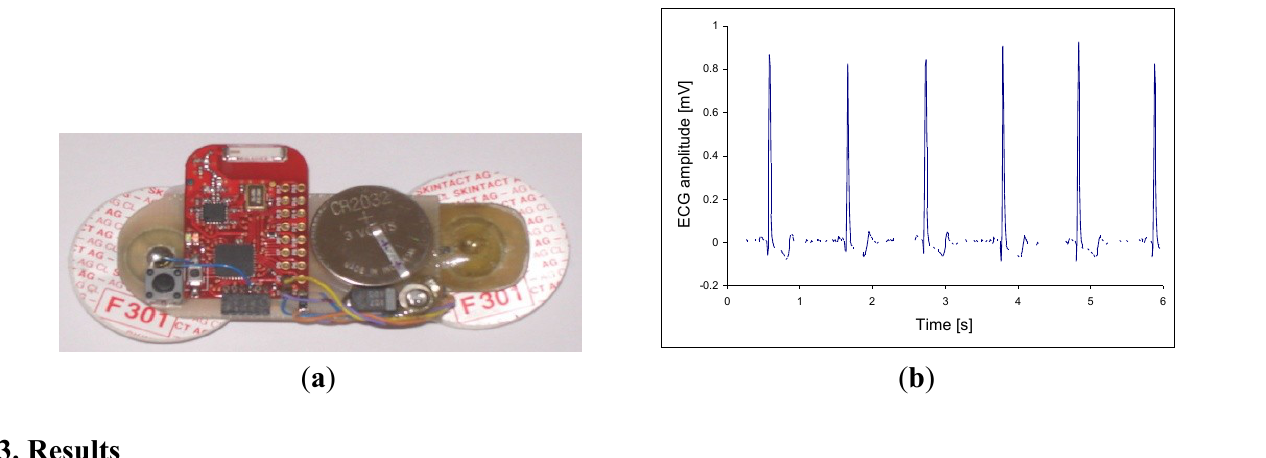
Figure 3. ( a ) Prototype of wireless respiration sensor with two, self-adhesive, disposable electrodes, a lithium coin battery, and a ceramic chip antenna. ( b ) Raw signal from the respiration sensor with ECG R-peaks modulated by